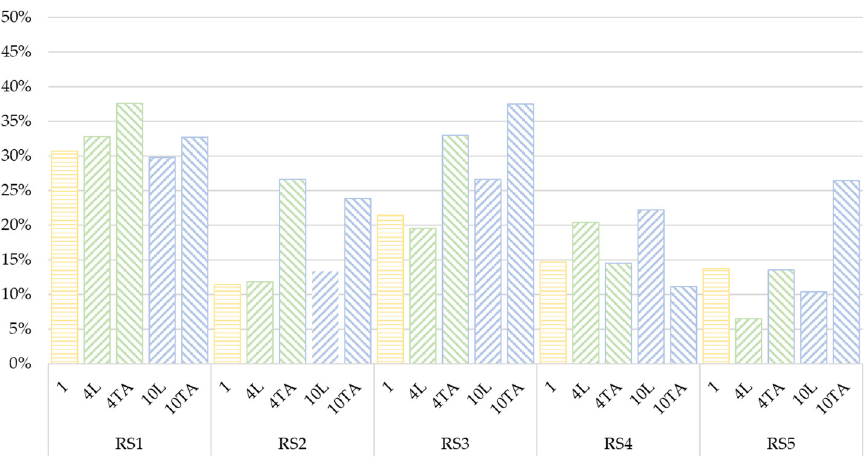
Figure 9. Level of non-compliance of 1.5 m of required lateral clearance per road section and cyclist group.